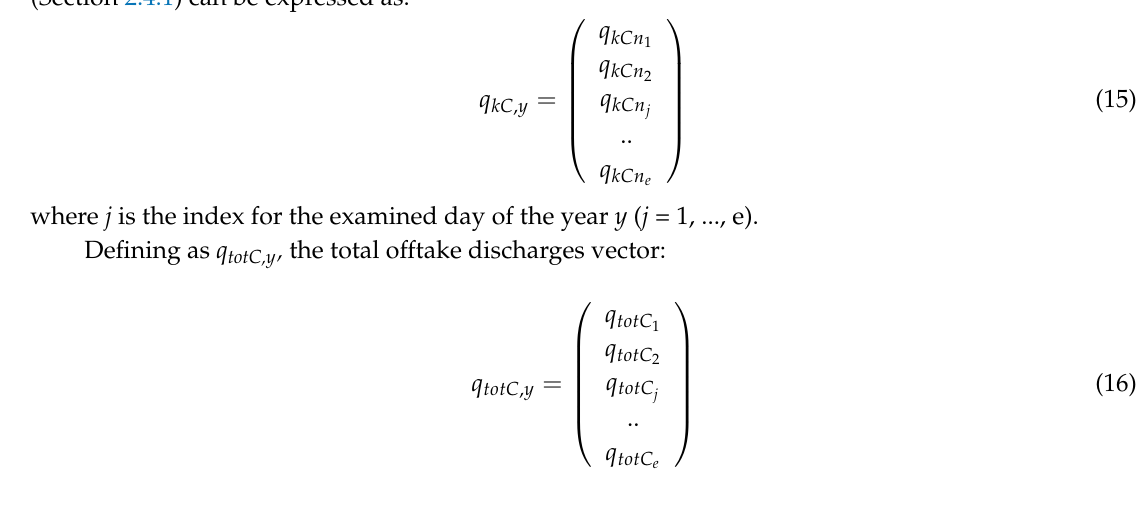
Figure 5. The scheme of ES: The 12 irrigation offtakes, the three culverts under passing the Idice River (Culv_1), the Navile Canal (Culv_3), and the Savena River (Culv_4), the two water gauges (WL OUT_0 and WL IN_1) at the OUT of the pumping station Pieve di Cento and at the IN of Culv_1, the two road crossings.